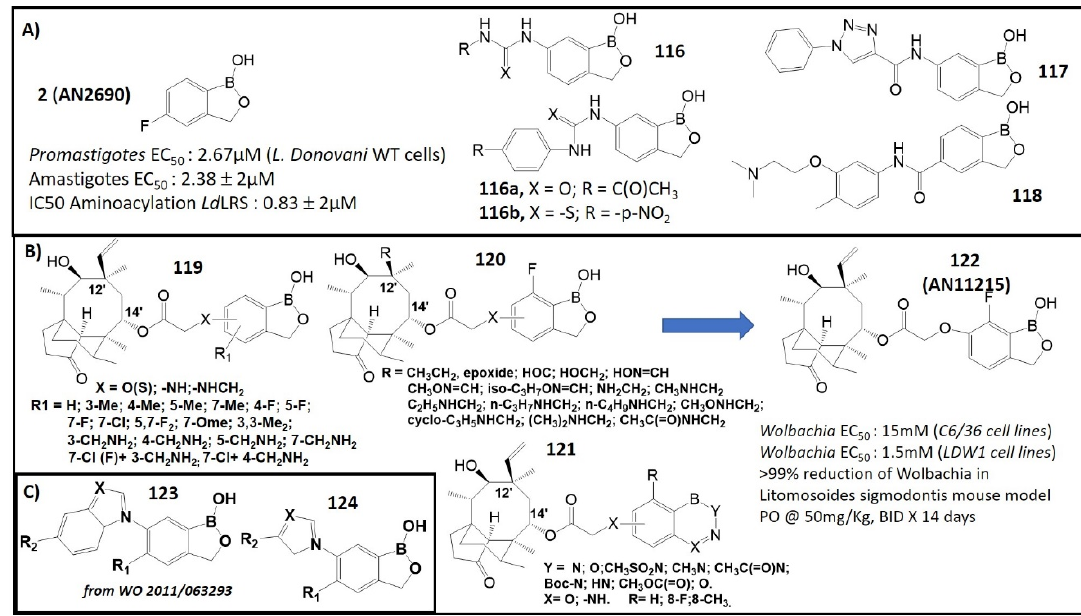
Figure 13. ( A ) Structures and antileishmanial activity of benzoxaboroles 2 and 116–118 (Adapted from [112,115,116]; ( B ) Structures of pleuromutilin–benzoxaboroles 119 – 121 and structure and anti-Onchocerca activity of 122 (Adapted from [117,118]); ( C ) Structures of benzoxaboroles 123 and 124